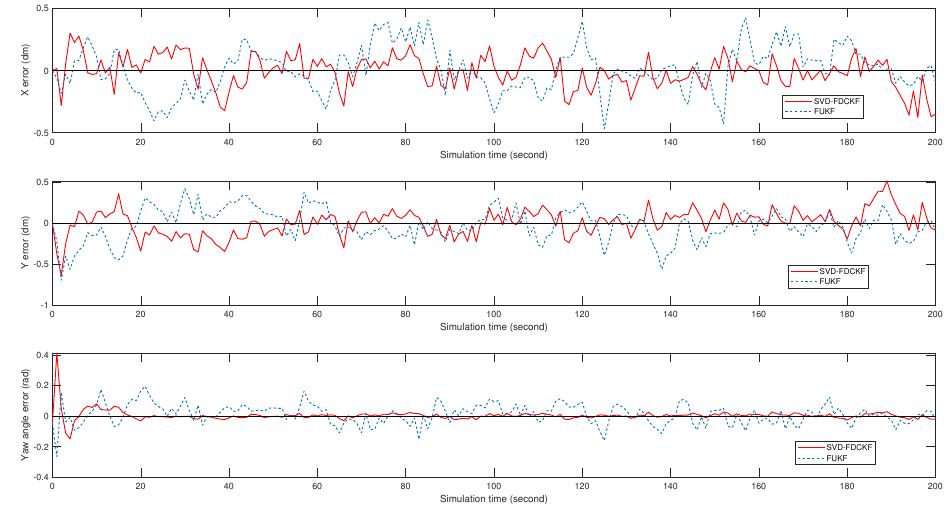
Figure 10. The attitude errors of mobile robots, including x coordinate, y coordinate, and yaw angle θ , are estimated by FUKF and SVD-FDCKF algorithms at 200 path points,